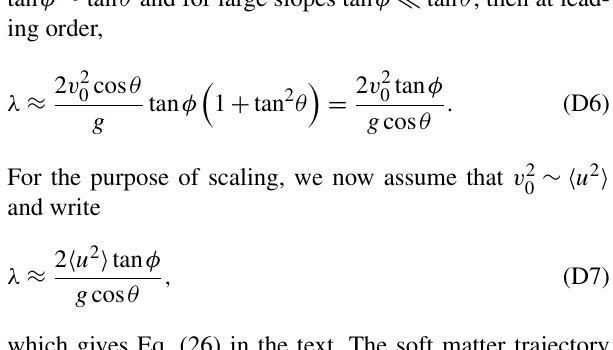
Figure E1. Definition diagram for idealized collision of a spherical particle with a rigid planar